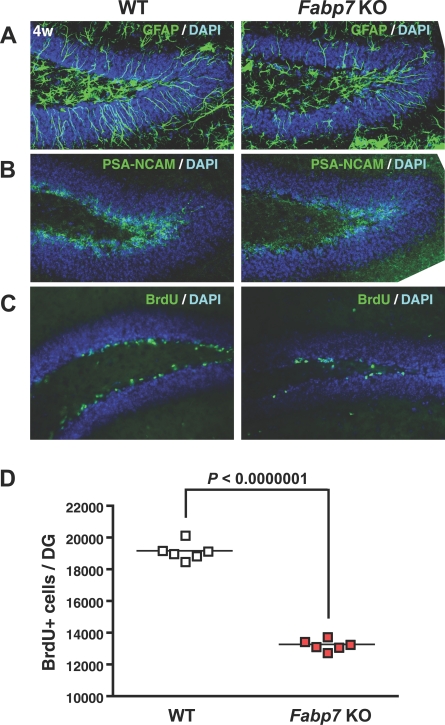
Neurogenesis in Wild-Type (WT) and Fabp7 Knockout (KO) Mice(A and B) In the hippocampal dentate gyrus at 4 wk, Fabp7-null mice show decreased expression of GFAP (a neural stem/early progenitor marker) and PSA-NCAM (a late progenitor marker).(C and D) The number of BrdU-incorporated cells is markedly reduced in Fabp7-null mice at 4 wk, suggesting a dramatic decrease in the production of new neurons.